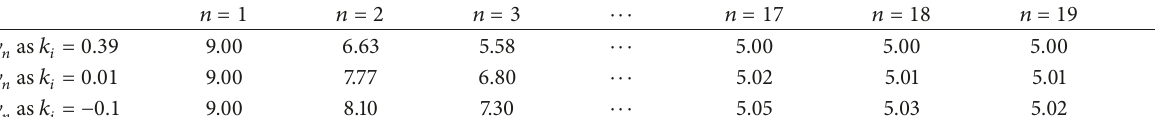
Table 1: Comparison for convergent rates of iteration scheme (3) with different 𝑘 𝑖 .